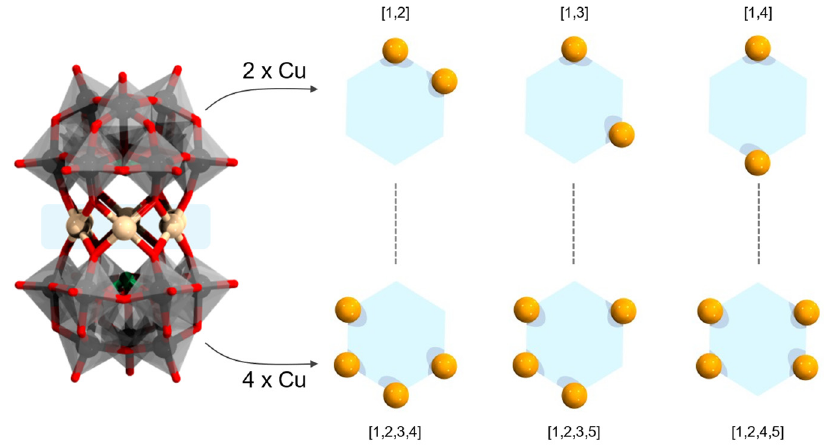
Figure 9. Generic sandwich {Cu n ( α -XW 9 O 33 ) 2 } ( left ); isomers when n = 2 ( top , right ) and n = 4 ( bottom , right ). Color code: X = green, partially occupied Cu = light orange, fully-occupied Cu = orange, {WO 6 } = gray octahedra, W = black, and O = red.